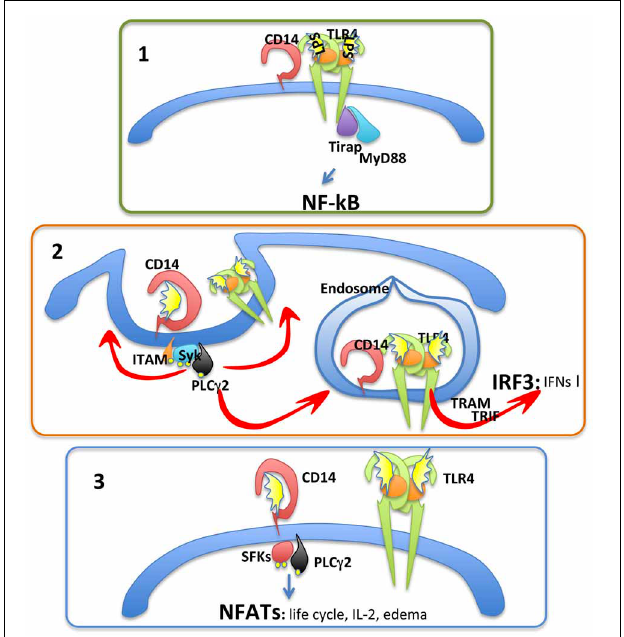
FIGURE 1 | CD14 has three fundamental functions. Panel 1 , CD14 favors optimal NF-kB-dependentcytokine production by allowing the recognition of low-LPS doses. Panel 2 , CD14 promotes TLR4 endocytosis and type-I IFN expression. Panel 3 , CD14 has autonomous signaling functions leading to the activation of NFATc transcription factor family members. The consequences of NFAT activation are mostly